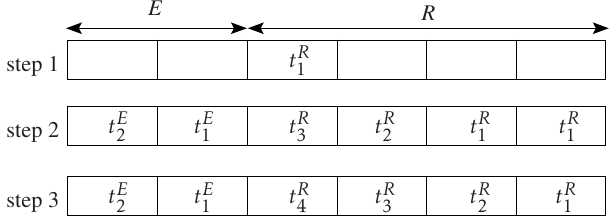
Figure 3. Example of the state of the E and R lists, at three different